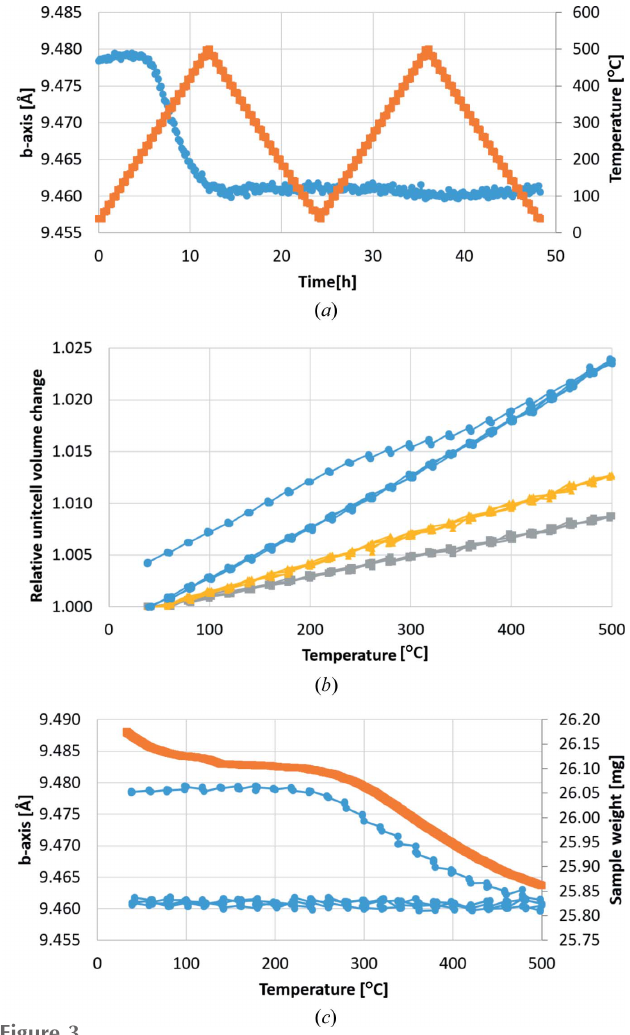
Figure 3 Observed changes in K-paracelsian during two cycles of heating. ( a ) Evolution of the b axis (blue) during the temperature programme shown in orange. ( b ) Relative changes in unit-cell volume of K-paracelsian (blue) and the reference feldspars (yellow = albite and grey = microcline). ( c ) Observed sample weight during the TGA experiment (orange) plotted together with observed b axis variations (blue) from the in situ XRD